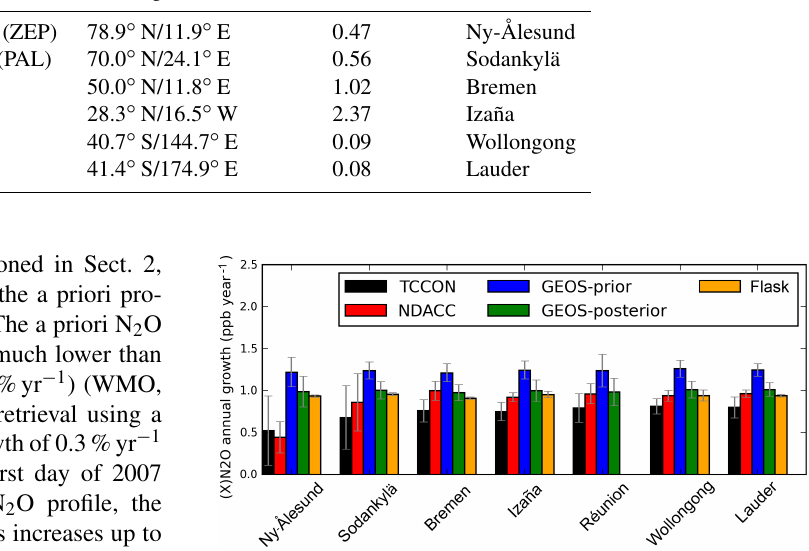
Figure 8. The X N trends from TCCON and NDACC FTIR mea- 2 O surements (all available data during 2007–2017; see Fig. 3), a priori and a posteriori model simulations (2007–2014), and surface N 2 O trend from flask sample measurements (2007–2014), together with their uncertainties at each